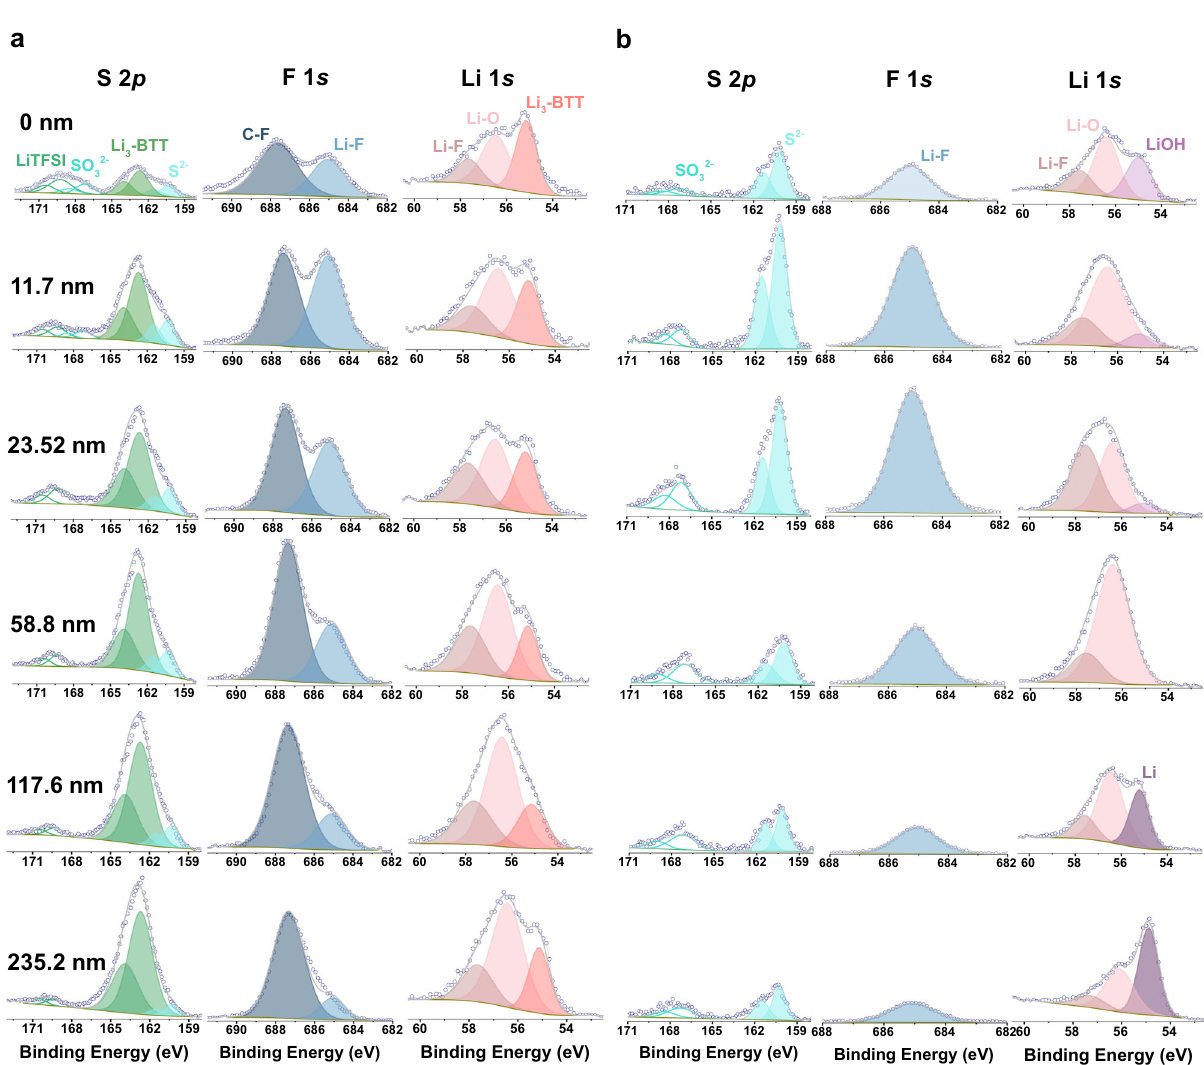
Fig. 3 XPS spectra with different etching depths layer for lithium foils. Two types of lithium foils were disassembled from symmetric cells with BTT and blank electrolyte after 10 cycles with a current density of 0.5 mA cm − 2 and a capacity density of 0.5 mAh cm − 2 . a S 2p, F 1s, Li 1s spectra for the BTT symmetric cell, and b for the control